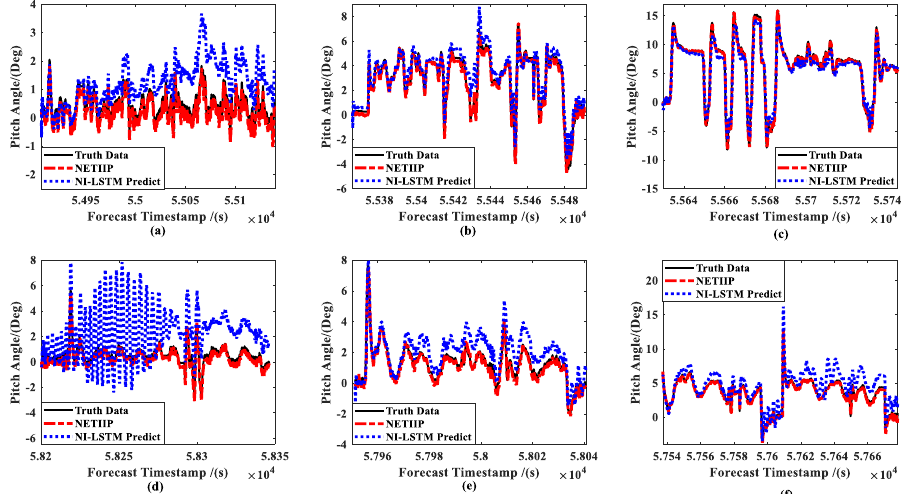
Figure 13. Comparison of ship attitude predictions: ( a ) slow speed of MRM, ( b ) medium speed of MRM, ( c ) high speed of MRM, ( d ) slow speed of ANM, ( e ) medium speed of ANM, and ( f ) high speed of ANM.